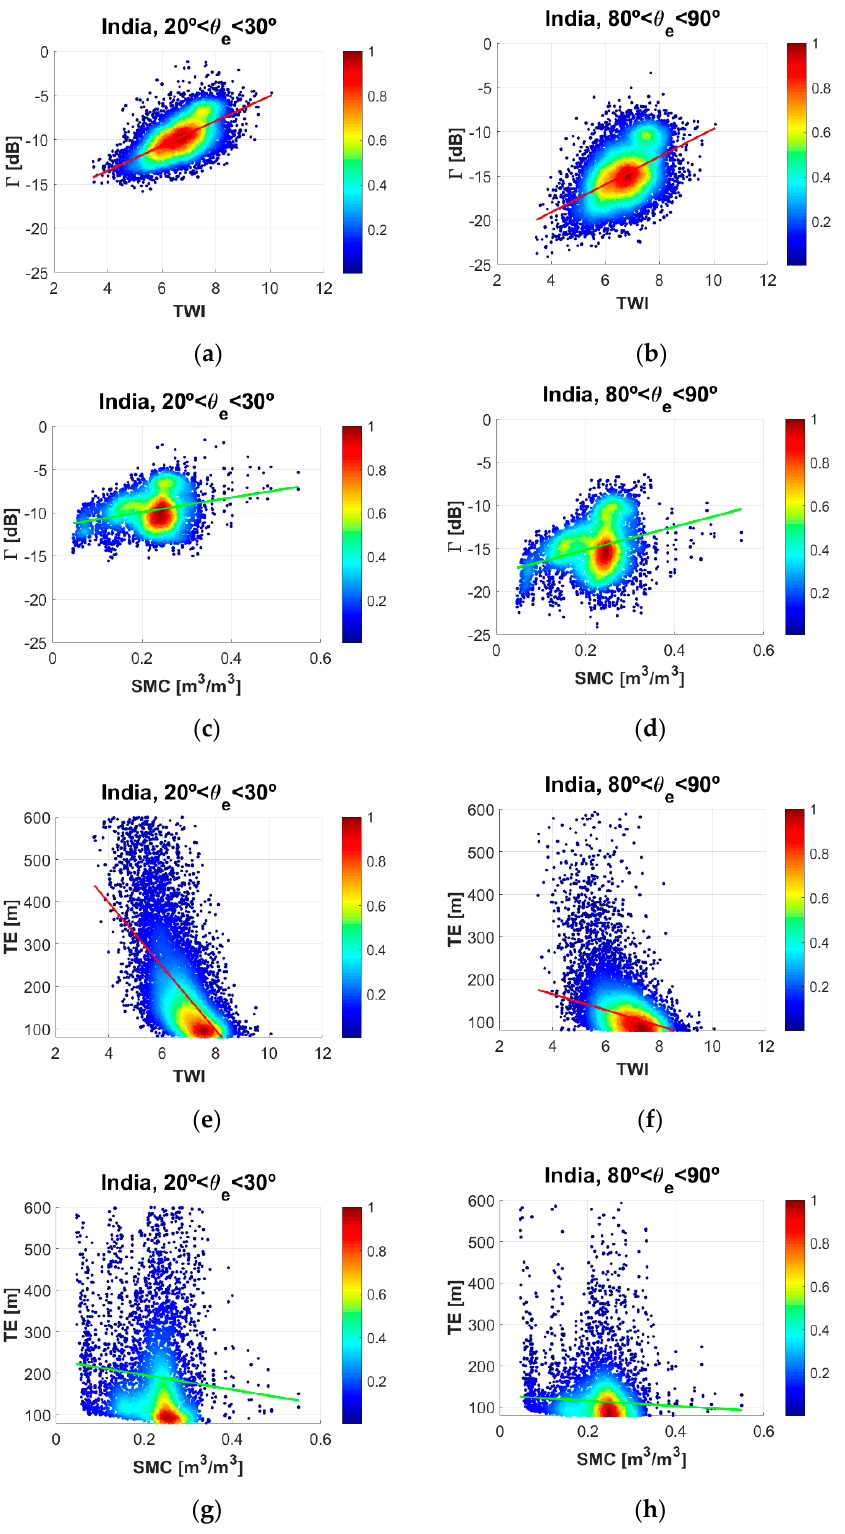
Figure 8. Density scatter plots over North India target area: CyGNSS-derived Γ vs. TWI at ( a ) θ e ~ [20, 30] ◦ and ( b ) θ e ~ [80, 90] ◦ . Γ vs. SMAP-derived SMC at ( c ) θ e ~ [20, 30] ◦ and ( d ) θ e ~ [80, 90] ◦ . TE vs. TWI at ( e ) θ e ~ [20, 30] ◦ and ( f ) θ e ~ [80, 90] ◦ . TE vs. SMC at ( g ) θ e ~ [20, 30] ◦ and ( h ) θ e ~ [80, 90] ◦